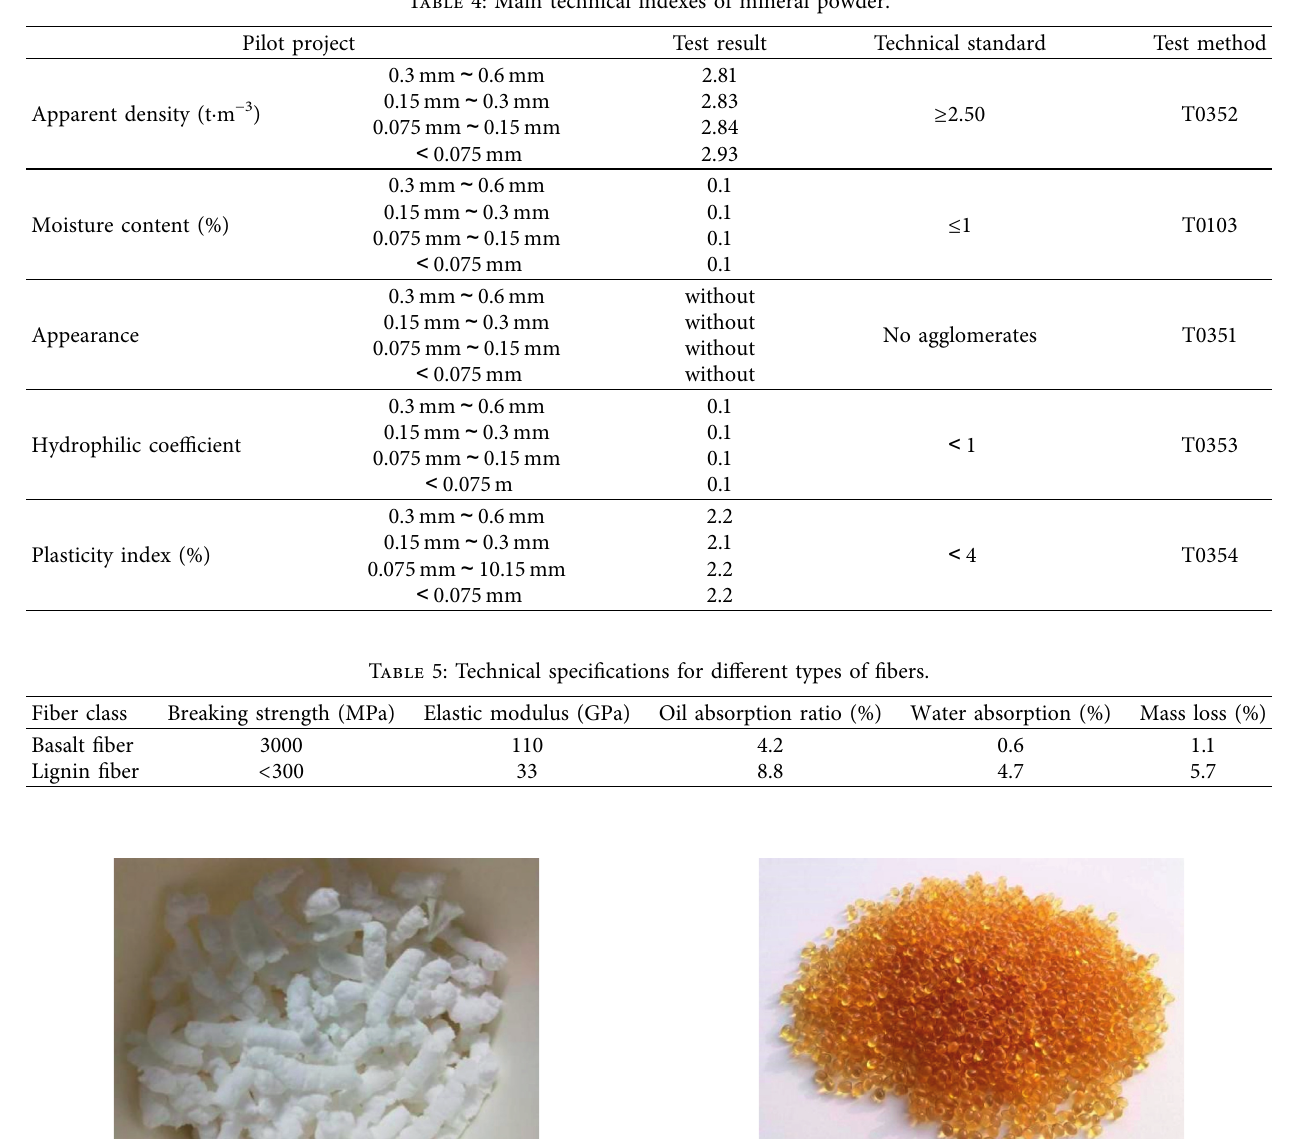
Table 4: Main technical indexes of mineral powder.